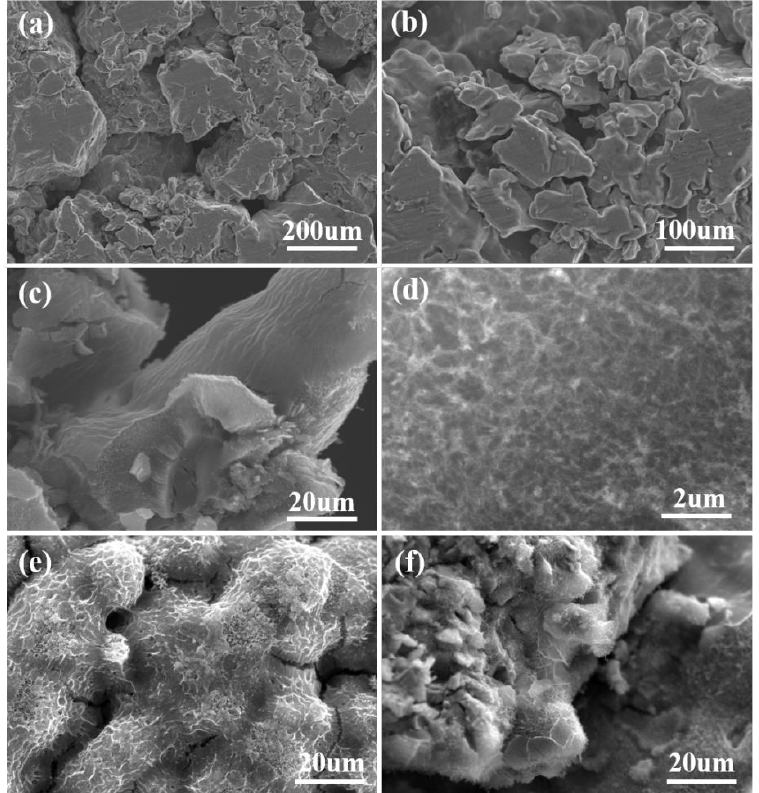
Figure 3. Scanning electron microscopy images of different structures of metal porous Ti ( a , b ), TiO 2 /Ti ( c , d ), and MnO 2 /TiO 2 /Ti nanocomposites ( e , f ).